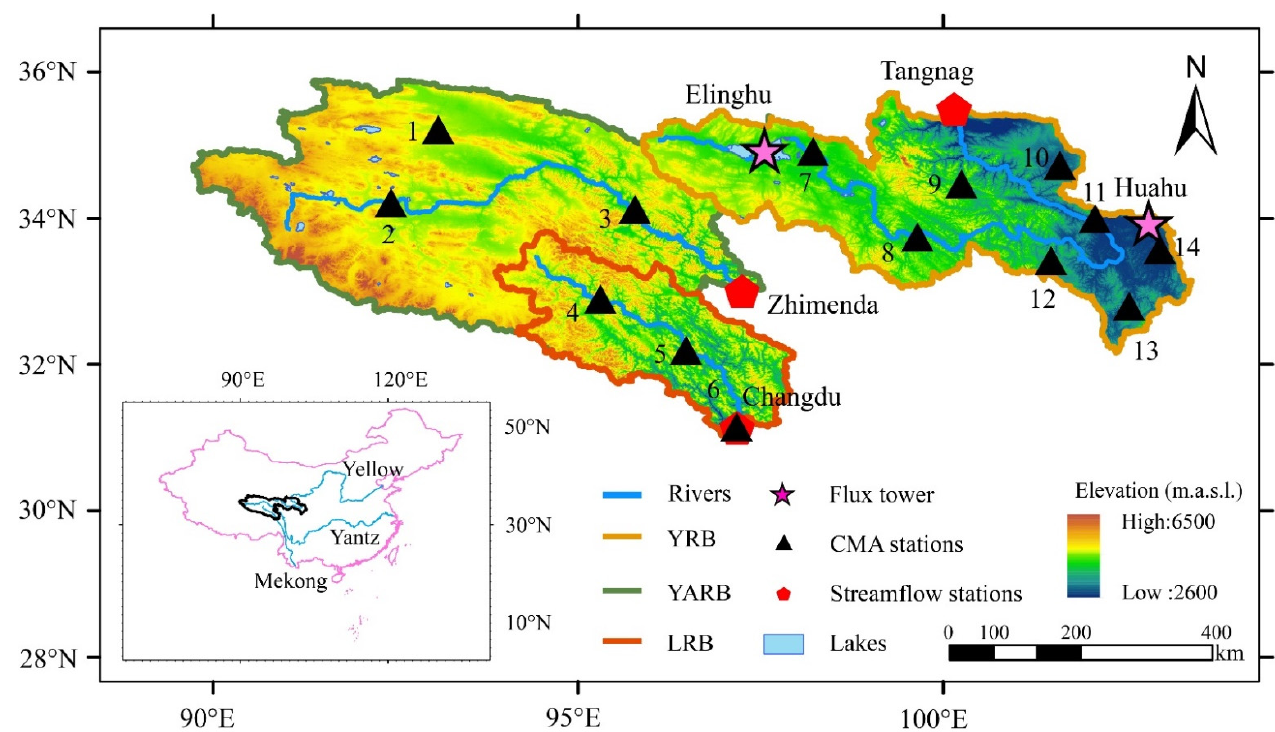
Figure 1. Geographic locations of the observational stations and source region of Three River basins (SRTR) include the Yellow River basin (YRB), the Yangtze River basin (YARB) and the Lancang River basin (LRB). The coordinates of streamflow stations, flux towers and meteorological stations are shown in Table 1.